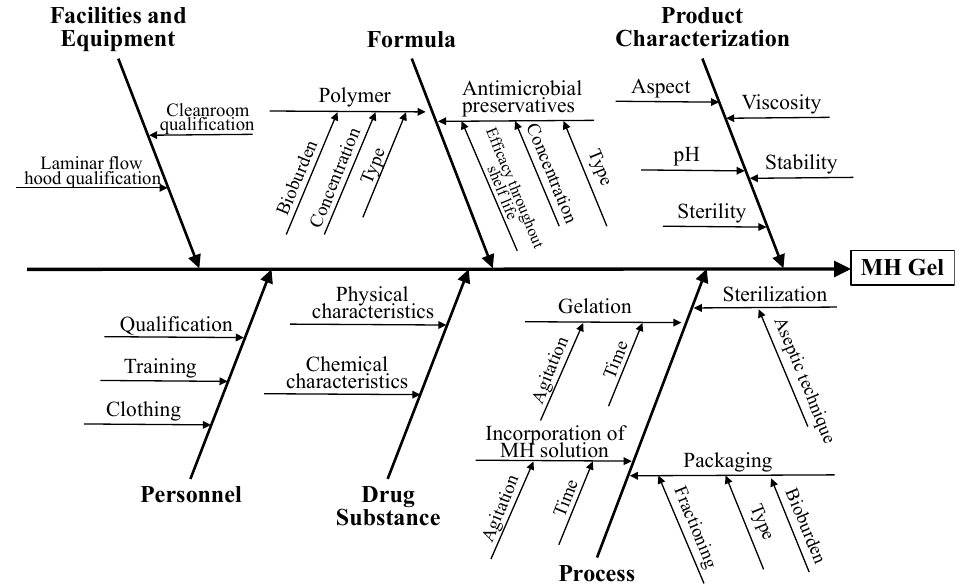
Figure 2. Ishikawa diagram illustrating factors that may have impact on the quality of MH-containing hydrogels for wound application.